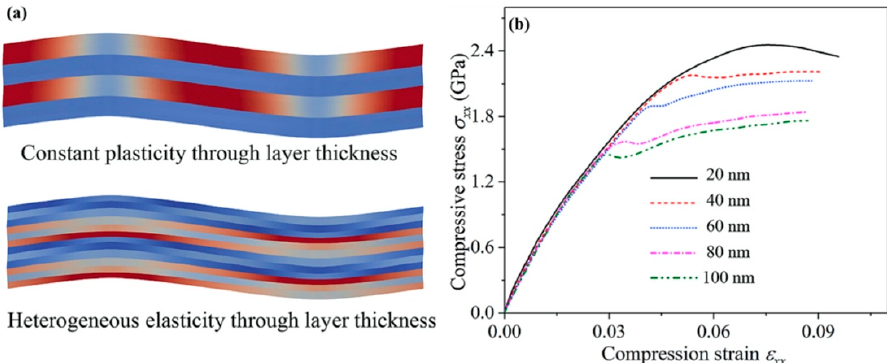
Figure 17. ( a ) A con fi ned layer slip-based crystal plasticity model for predicting the bulking behav- ior of nanolaminates. ( b ) E ff ects of the layer thickness on stress–strain curves under parallel com- pression, and a fi ne size has good plastic co-deformation and high resistance to compression bulking